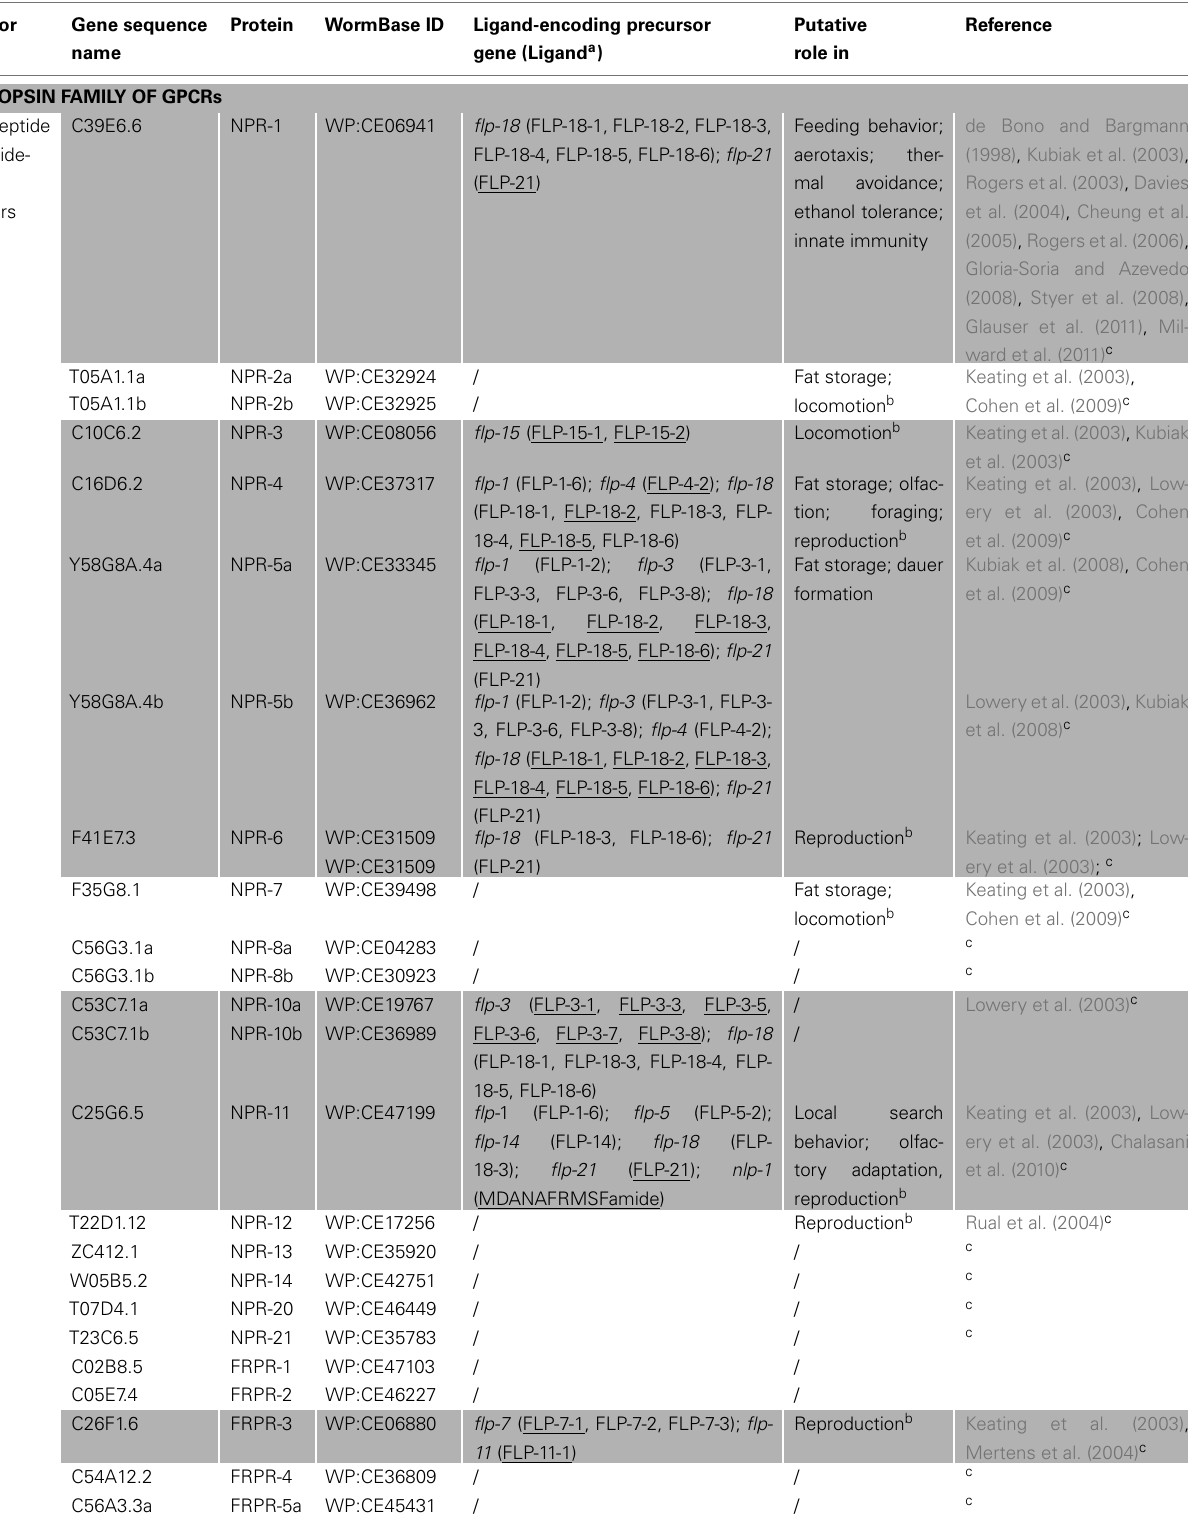
Table 1 | List of orphan and deorphanized neuropeptide GPCRs in C. elegans (adapted fromWormAtlas et al., 2002–2012). Receptor Gene group